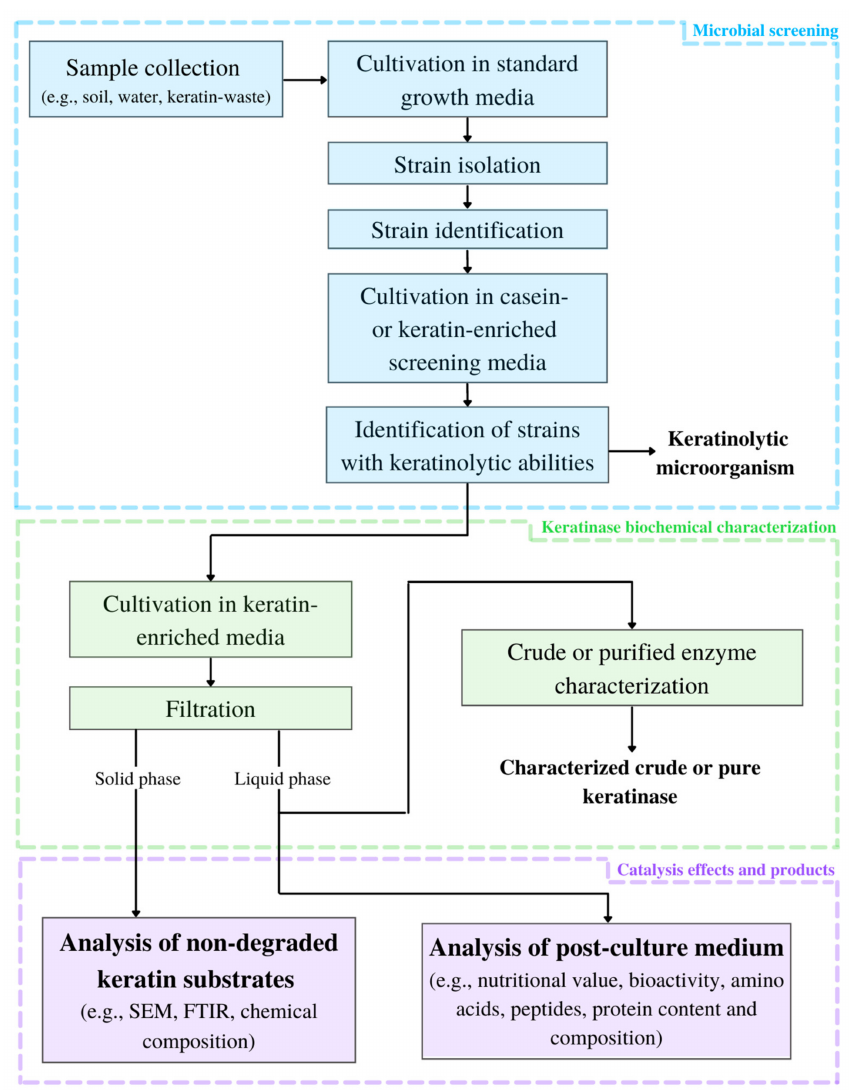
Figure 1. Framework for keratinolytic enzyme characterization (SEM—scanning electron microscope; FTIR—Fourier transform infrared